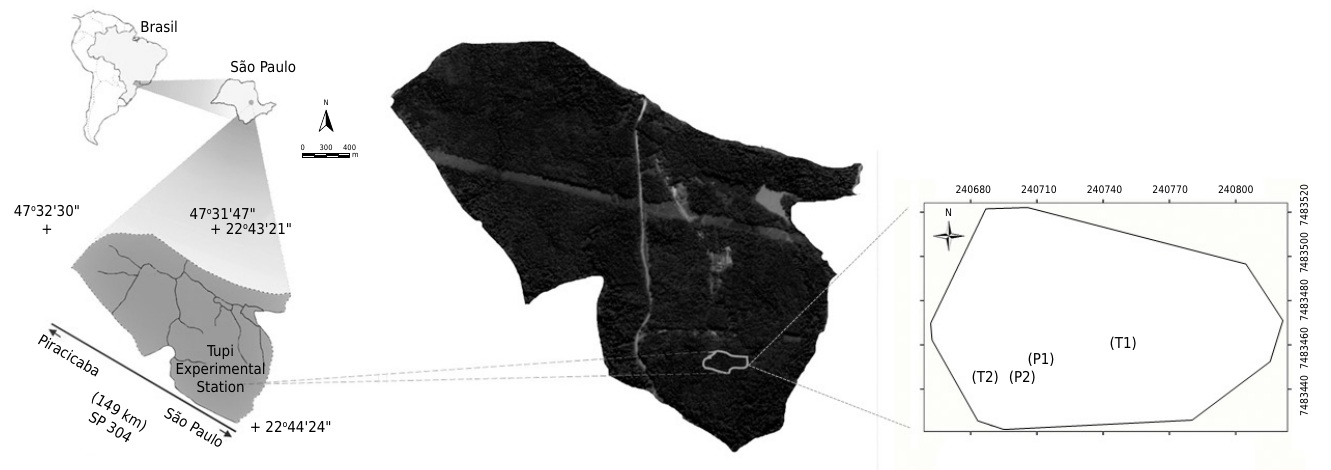
Figure 1. Location of the Tupi Experimental Station, and-highlighted, the area selected for this